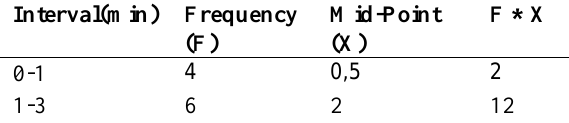
Table 4. Results of the Survey and Sub-sequential Calculations with the